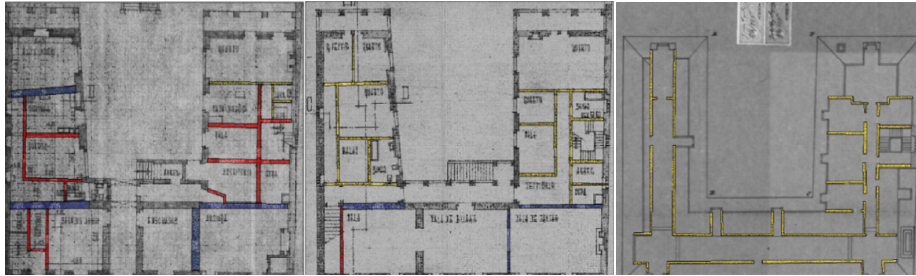
Figure 11. Plans of the three levels showing distinct types of walls.